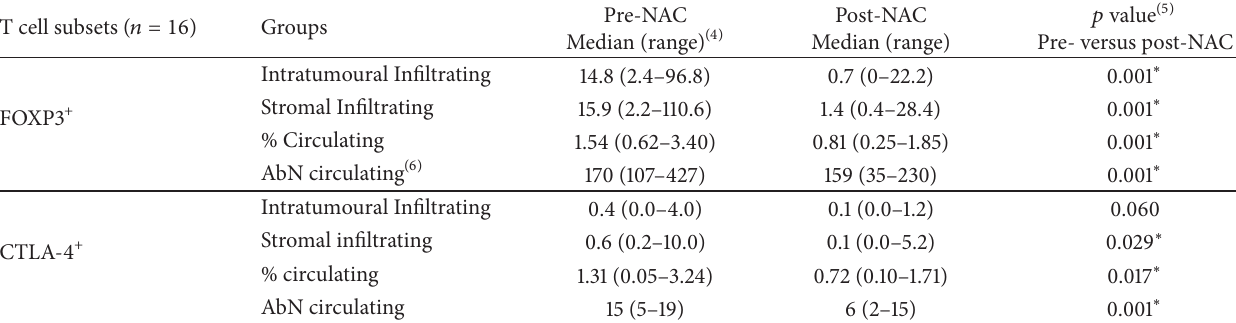
Table 6: Blood (1) and tumour-infiltrating FOXP3 + and CTLA-4 + T cells in women with LLABCs (2) : significant reduction with NAC (3) . T cell subsets ( 𝑛 = 16